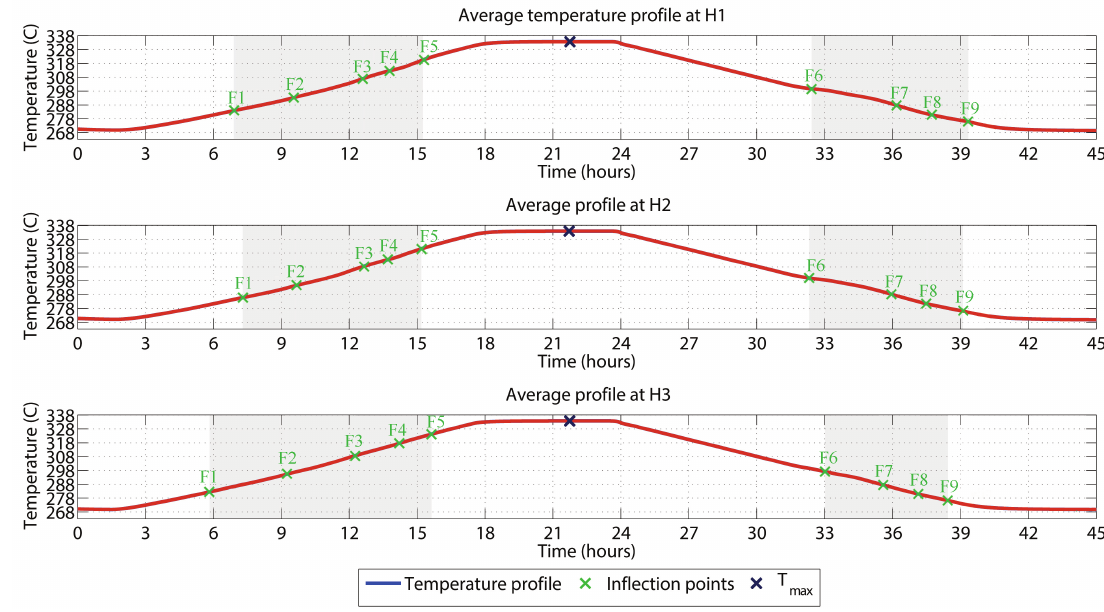
Figure 8. Animal fat average thermal profiles with the specific maxima and inflection